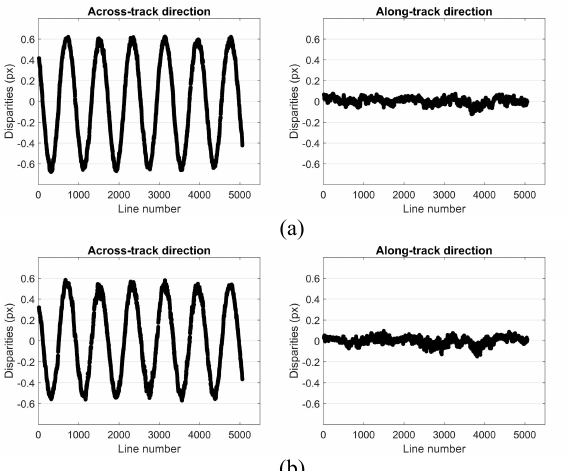
Figure 9 . Parallax disparities between (a) B1-B2 and (b) B2-B3 from parallax maps obtained using phase correlation matching Based on the framework of jitter compensation, jitter curve was Figure 7 . Parallax disparities between (a) B1-B2 and (b) B2-B3 estimated. The detected parameters of jitter curve are shown in from parallax maps obtained using correlation coefficient and Table 2. In order to measure the accuracy of the acquired jitter least squares matching curve, a 1-m orthophoto image was used as the reference image to obtain the truth value of the jitter curve. The obtained